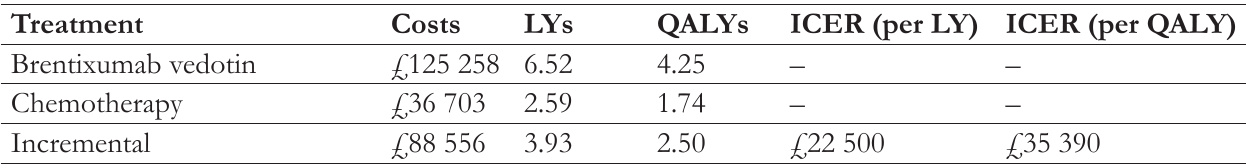
Table 3. Base Case Cost-effectiveness